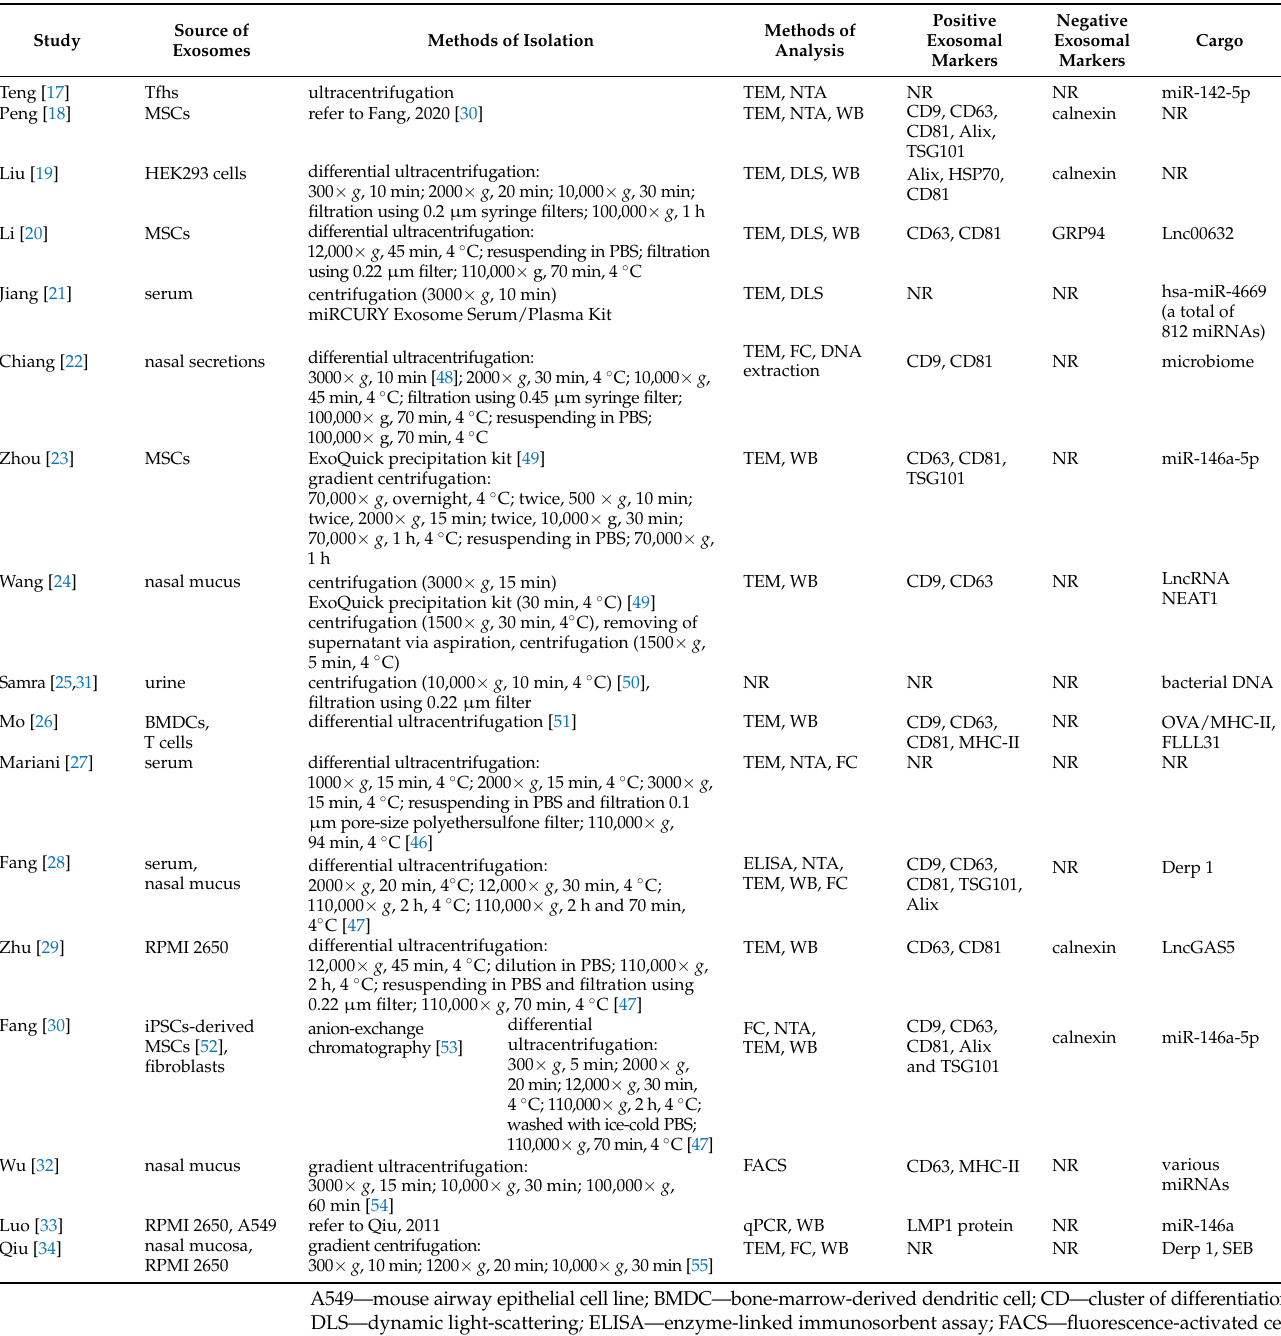
Table 2. Exosome information in the included